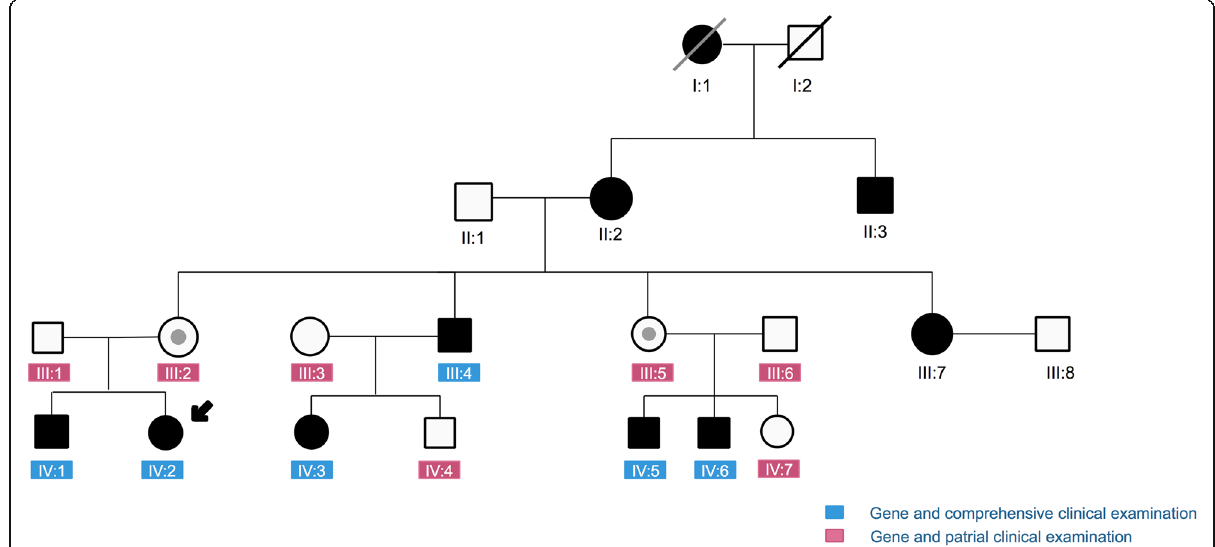
Fig. 2 Pedigrees of this Chinese family. Filled symbols demonstrate affected patients and unfilled symbols demonstrate unaffected patients. The dotted circles show female carriers. Arrow indicates the proband. Red indicates that patients underwent a genetic test and partial clinical examination. Blue indicates that patients underwent a genetic test and complete clinical